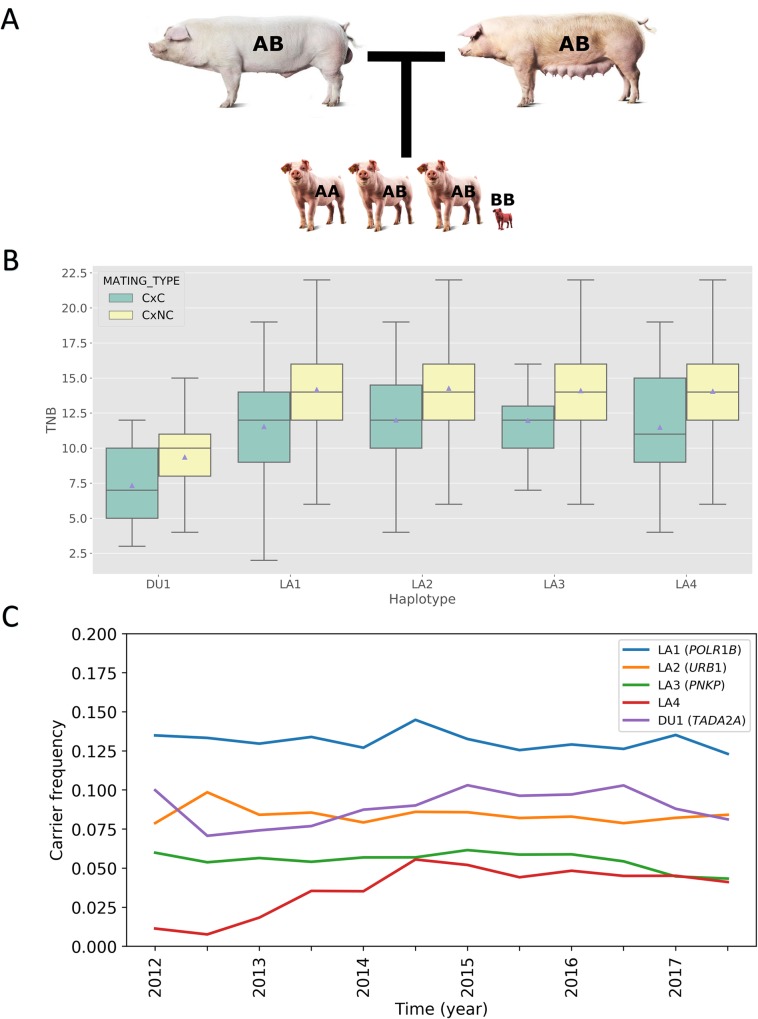
A) Example of a carrier-by-carrier mating in Landrace. CxC litters will result in a 1:2 genotype ratio instead of the normal 1:2:1 genotype ratio. B) Fertility phenotypes for lethal recessives. A significant reduction in total number born (TNB) is observed for CxC compared to CxNC matings. C) Carrier frequency for lethal alleles in the period 2012–2018. Figure shows relative stable carrier frequencies over a time period of 6 years (except for LA4).